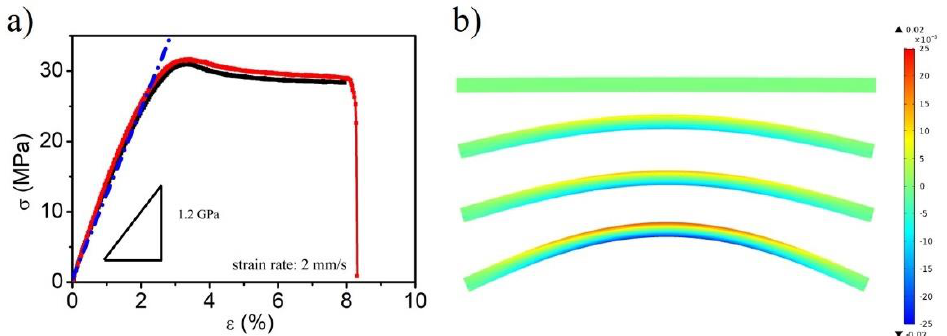
Figure 1. The mechanical properties of the polylactic acid (PLA) substrate ( a ) and the strain simulation map of the electrode under different mechanical bending ( b ).